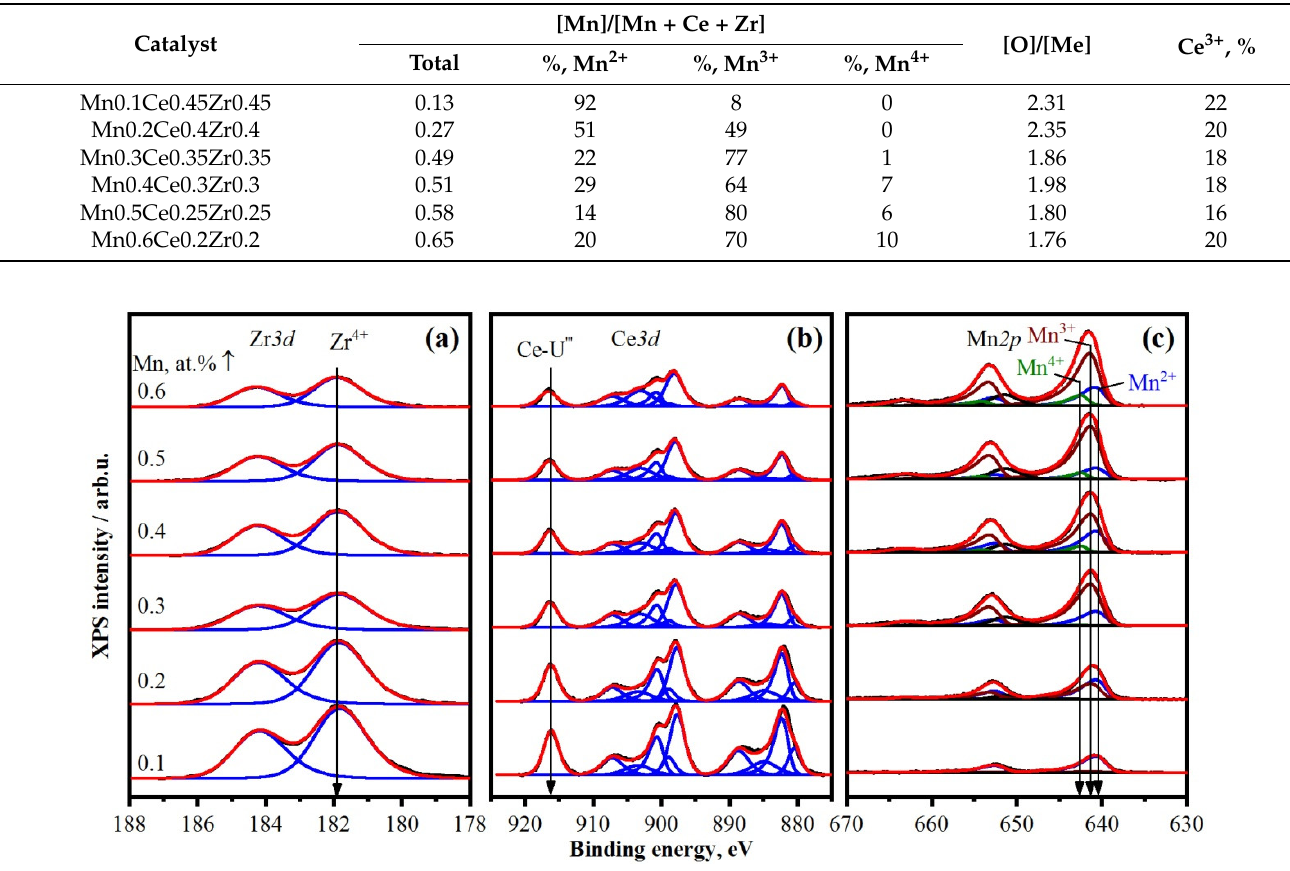
Figure 8. XPS Zr 3d ( a ), Ce 3d ( b ), and Mn 2p ( c ) core-level spectra of the Mn(x)Zr(0.5 − x/2)Ce(0.5 − x/2) catalysts. Ce 3d and Mn 2p spectra are normalized to the integral intensity of the corresponding Zr 3d spectra.